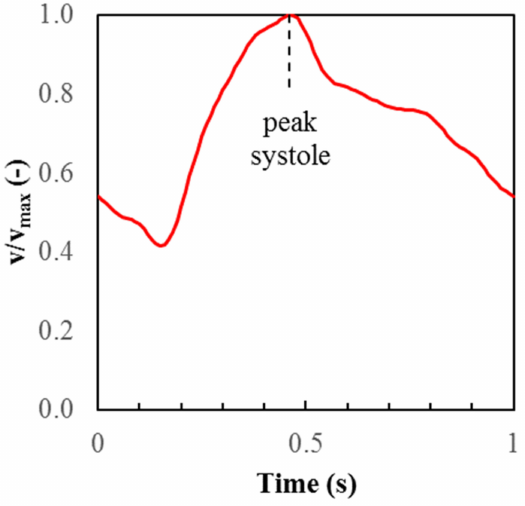
Figure 1. Normalized inlet centerline velocity profile throughout the cardiac